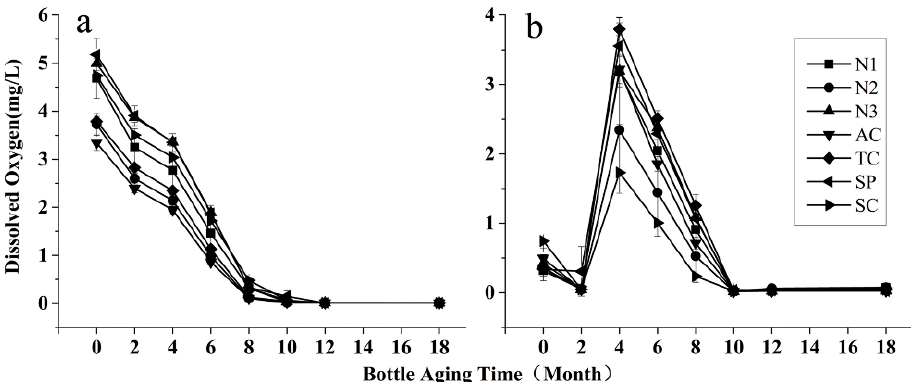
Figure 2. Change trends of DO in rosé ( a ) and white wines ( b ) during an 18-month bottle aging. (Symbols and abbreviations: N1: natural cork-1; N2: natural cork-2; N3: natural cork-3; AC: agglomerated cork; TC: ‘1+1 ′ technical cork; SP: polymer synthetic plug; SC: screw cap.)